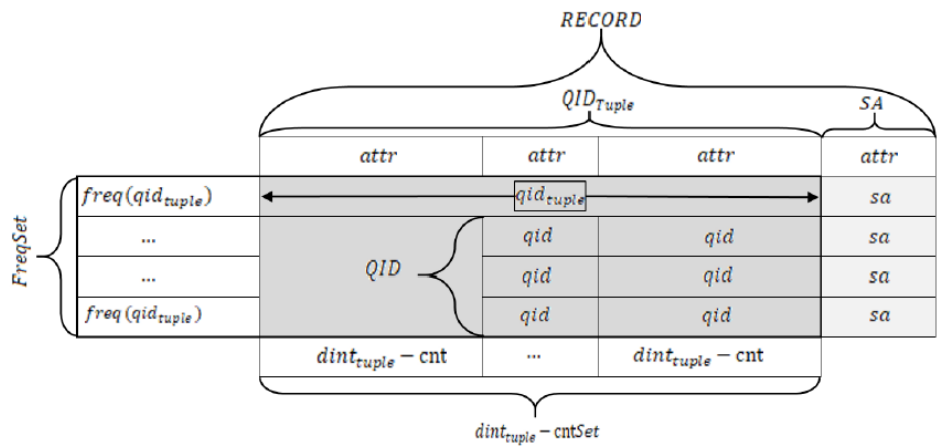
Figure 4. Notations Mapped for a Database